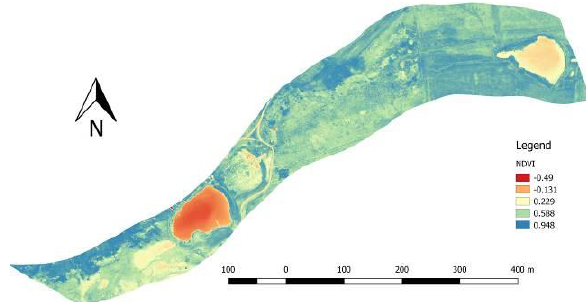
Figure 5. NDVI calculated from the AS dataset.